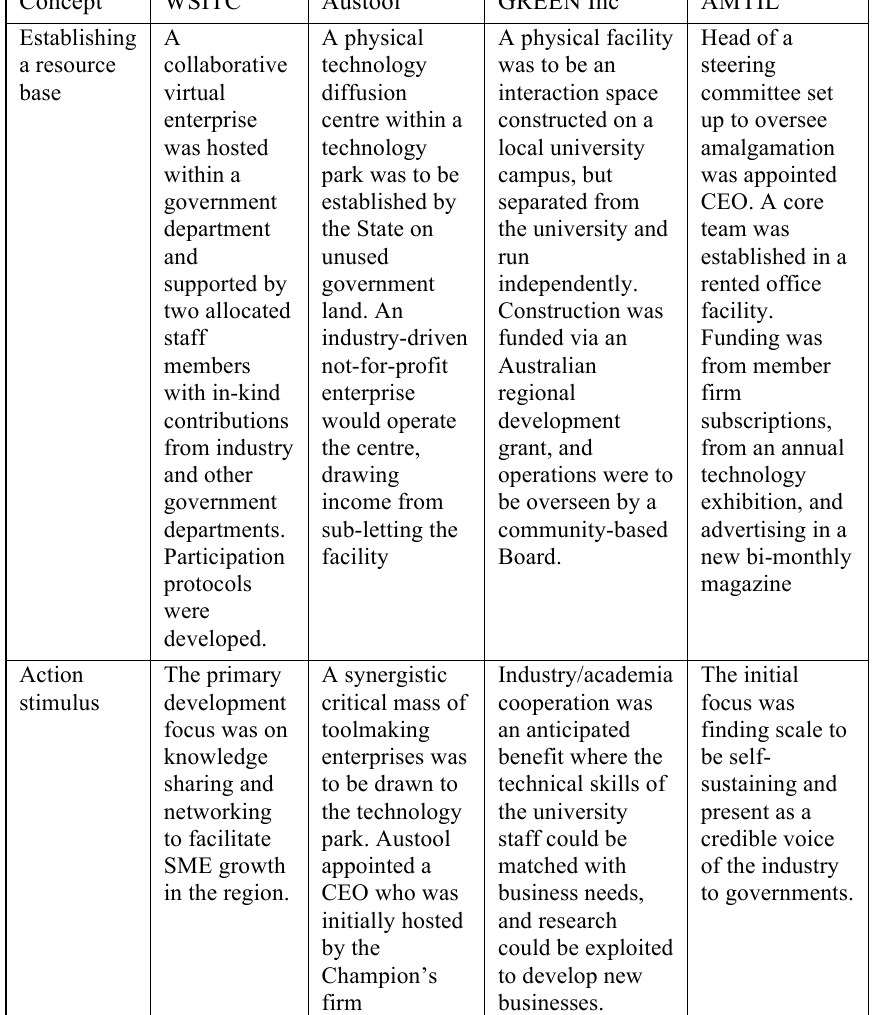
Table 5. Development phase